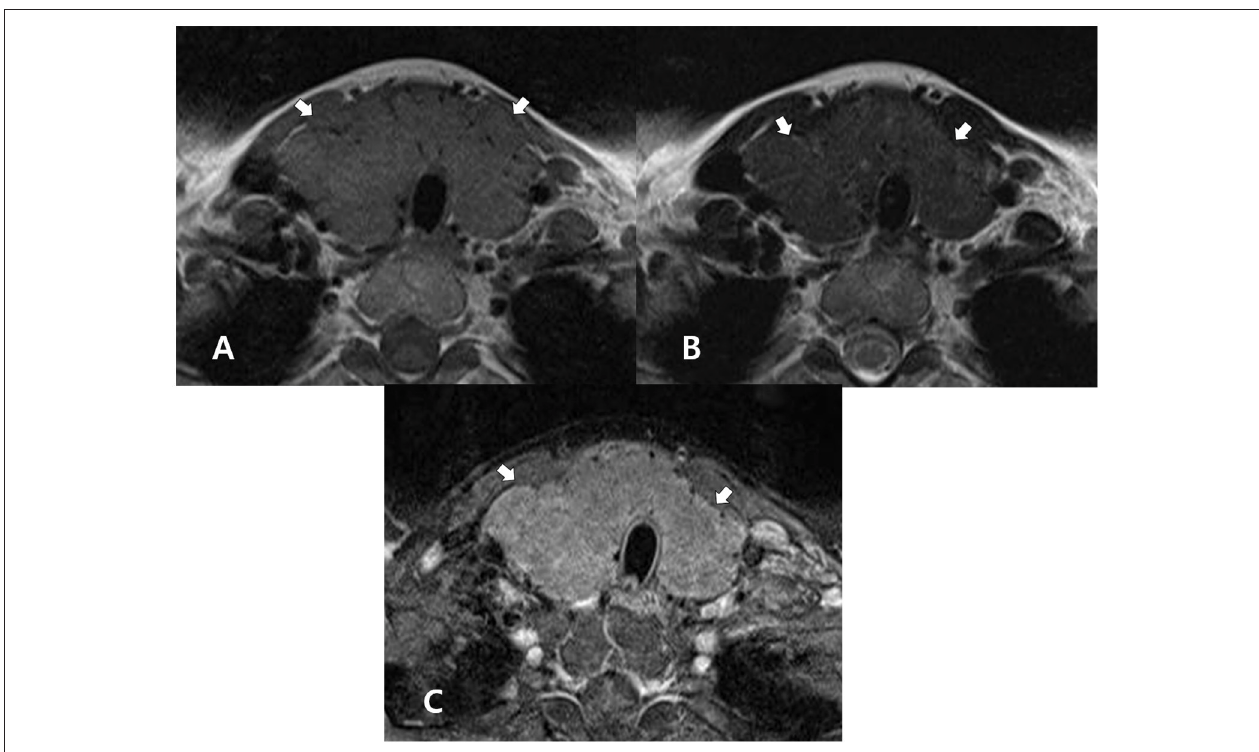
FIGURE 3 | A 44-year-old woman with diffuse hyperplasia confirmed by histopathology after thyroid surgery for the treatment of papillary thyroid carcinoma. In the non-enhanced axial T1- (A) and T2- (B) weighted images, the thyroid gland (arrows) exhibits homogeneous, iso-. and slightly increased signal intensity, respectively, when compared with the adjacent muscle. In both images, the thyroid gland (arrows) exhibits increased size and a lobulated margin. In the enhanced axial, fat-suppression T1-weighted image (C) , the thyroid gland (arrows) exhibits increased, but inhomogeneous enhancement, when compared with adjacent